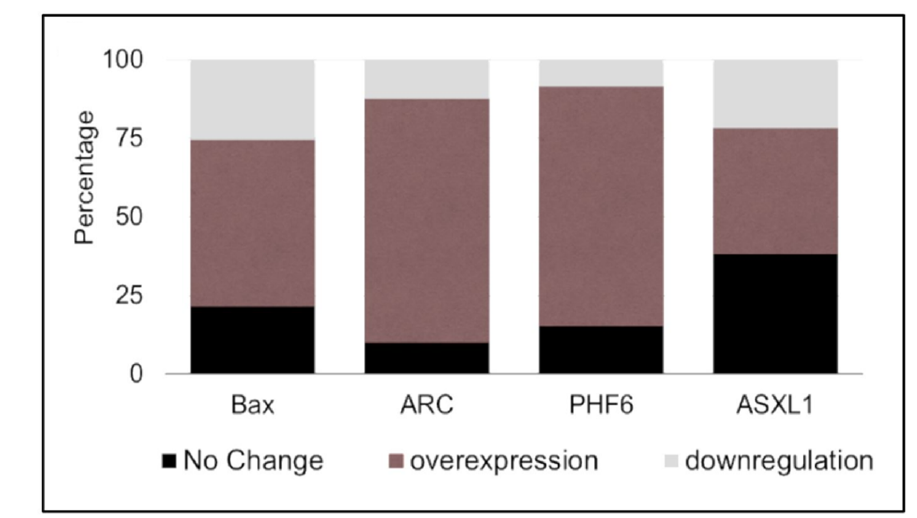
Figure 5 - Distribution of markers in AML patients. Graphical representation of the expression profiling of the selected markers showing the percentage of patients that showed no change or exhibited overexpression or